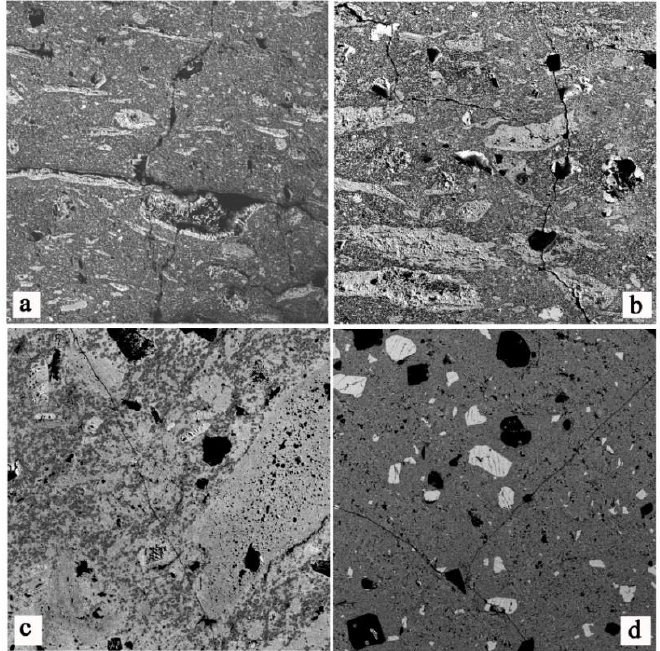
Figure 2. Whole-section Al X-ray maps show the petrographic characters of Tertiary volcanic tuff (brighter patches in the image indicate a higher amount of aluminum content, vesicles show as dark in the image, except in ( d ), where quartz shows as dark). Each image covers 2 cm 2 area. ( a ) Densely welded tuff, all pumices are flattened. ( b ) Partially welded tuff, pumices form lens shape. ( c ) Non-welded tuff, gas vesicles are preserved in the pumice. ( d ) Rhyolite, sanidine and quartz phenocrysts are randomly distributed in the matrix.